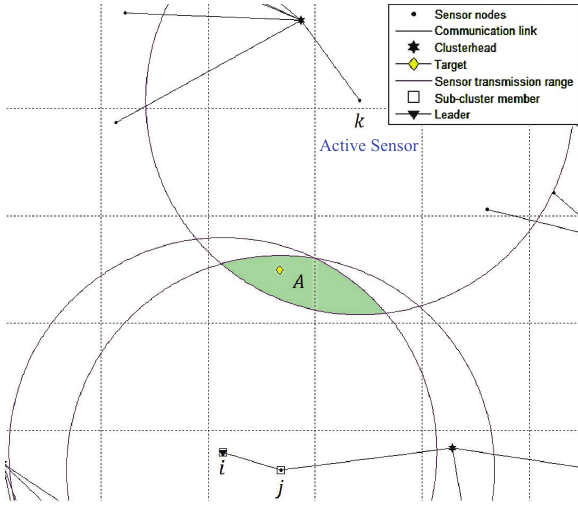
Figure 6. The bounding area A of CTCI.